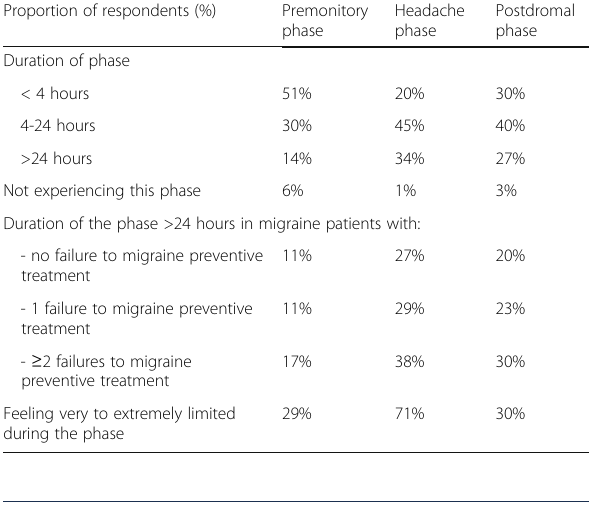
Table 1 (abstract P65). Description of the migraine phases Proportion of respondents